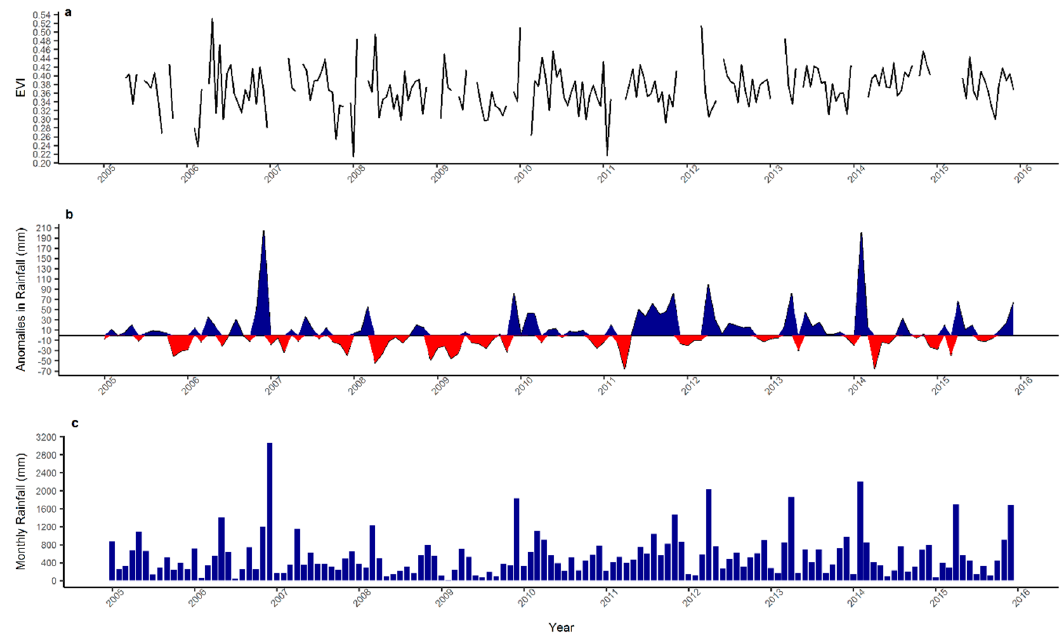
Figure 5. Temporal profiles for the Aberdare National Park showing ( a ) EVI from MODIS spatially averaged over the study area; ( b ) Anomalies in rainfall computed from monthly Tropical Applications of Meteorology using SATellite (TAMSAT) data; ( c ) Monthly rainfall estimates from TAMSAT data.